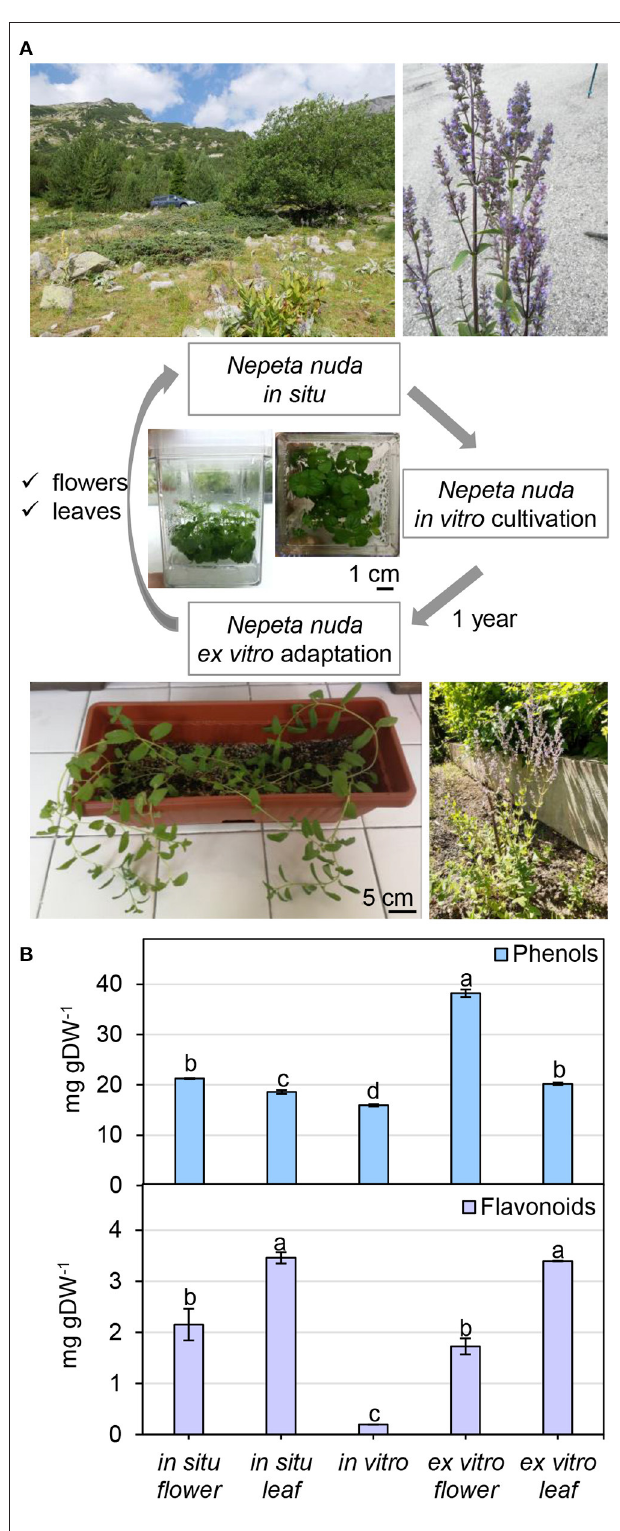
FIGURE 4 | Nepeta nuda phenolics in in situ , in vitro and ex vitro growth conditions. (A) N. nuda variants: location and photograph of a plant from in situ population; in vitro plants at 5 weeks; ex vitro adapted plants for 1 year.